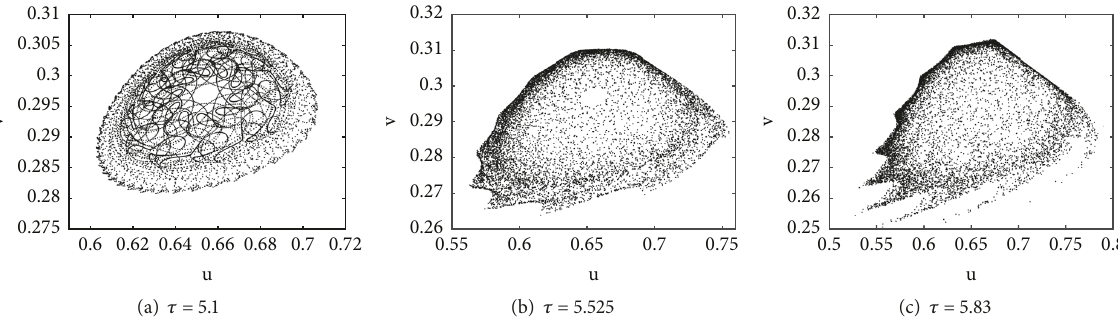
Figure 11: Phase portraits corresponding to the change of state variables in lattice (100, 100) of Figures 8–10 with the increase of